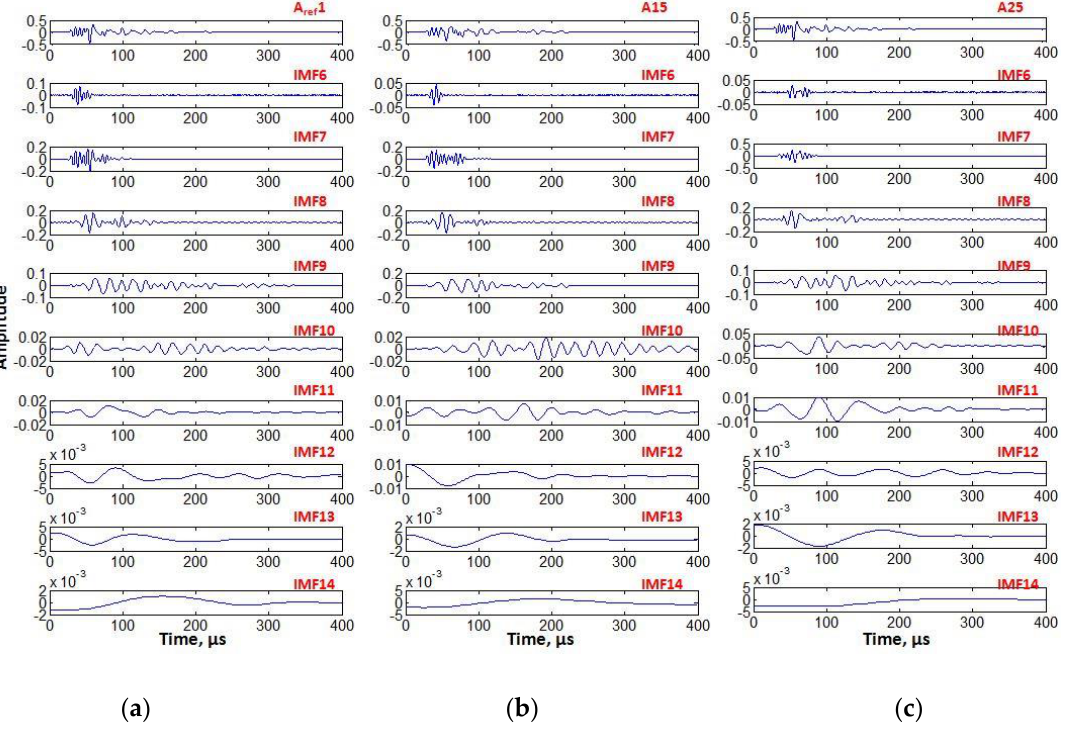
Figure 10. Intrinsic modes by EEMD decomposition: showing the informative intrinsic modes (IMF6–IMF14) of defect-free signal ( a ); 15 mm defective signal ( b ); and 25 mm defective signal ( c )